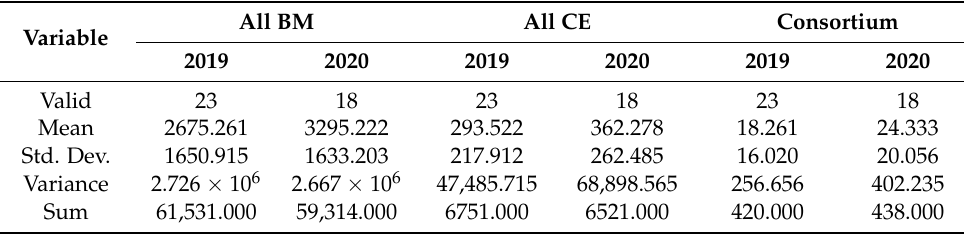
Table 9. Aggregated occurrence of verbal semantic indicators in CR COMPANIES. All BM All CE Variable